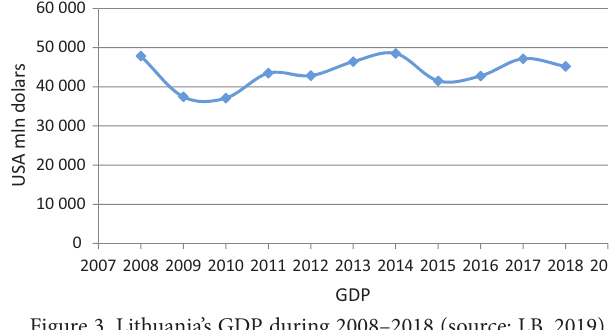
Figure 3. Lithuania’s GDP during 2008–2018 (source: LB,